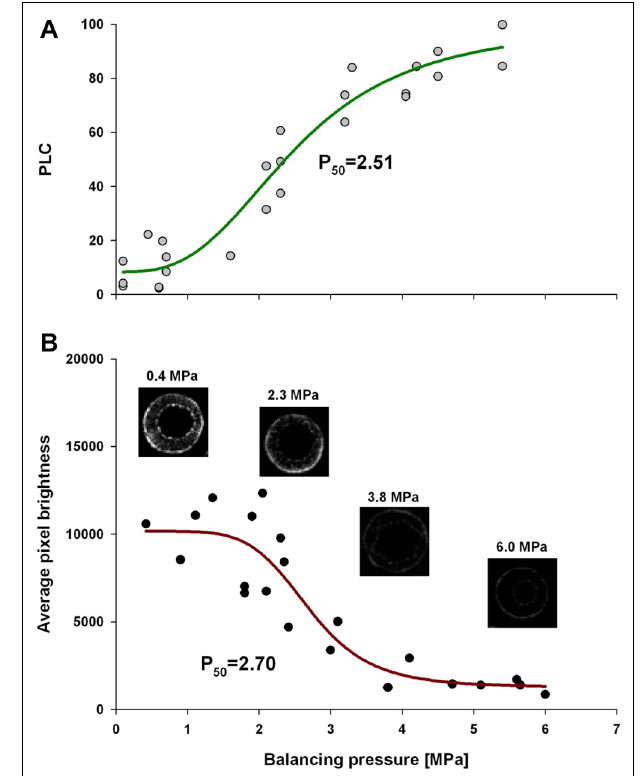
FIGURE 1 | Leaf water potential, measured on equilibrated branches, are plotted to PLC (A), and average pixel brightness (black = 0 to white = 65525) determined from MRI analysis (B), is shown. Both data sets were fitted with a dose–response curve (solid line) in the form of PLC = min PLC + (max PLC − min PLC )/[1 + (C/EC 50 ) slope ], where min PLC is minimum PLC in non-stressed plants, max PLC is 100%, EC 50 represents 50% loss of initial functionality [min PLC + (max PLC − min PLC )/2], and slope is the rateof PLC increase at EC 50 .There was no statistical difference between EC 50 from two methods (PLC and MRI).The same function was used for pixel brightness curve fitting except that min PLC and max PLC were substituted with average pixel brightness at low and high ends of stem water stress.The four MRI images shown are representative images that were used to create the MRI-vulnerability curve. Only pixel brightness data from the xylem conducting area was used to produce the curve. All measurements were made on current-year extension